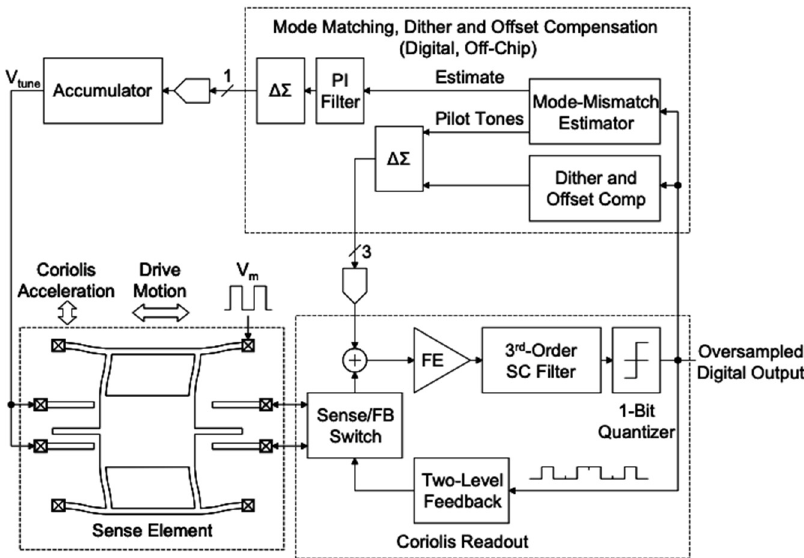
Figure 9. Gyroscope readout circuit